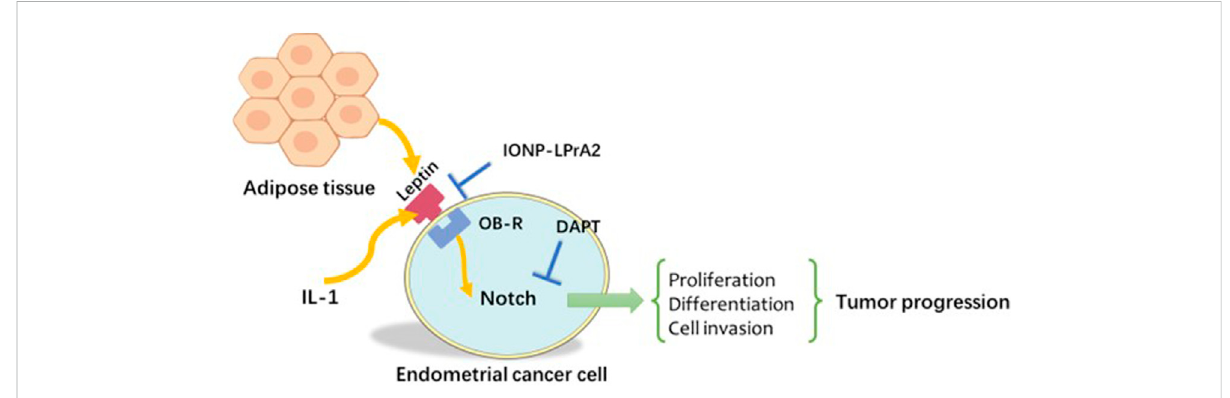
FIGURE 3 Notch, IL-1, and leptin crosstalk outcome (NILCO). Leptin induced Notch receptor, ligand, and targeted molecule expression. The inhibition of Notch and IL-1 signalling in vitro reduced leptin-induced invasion. IL-1: